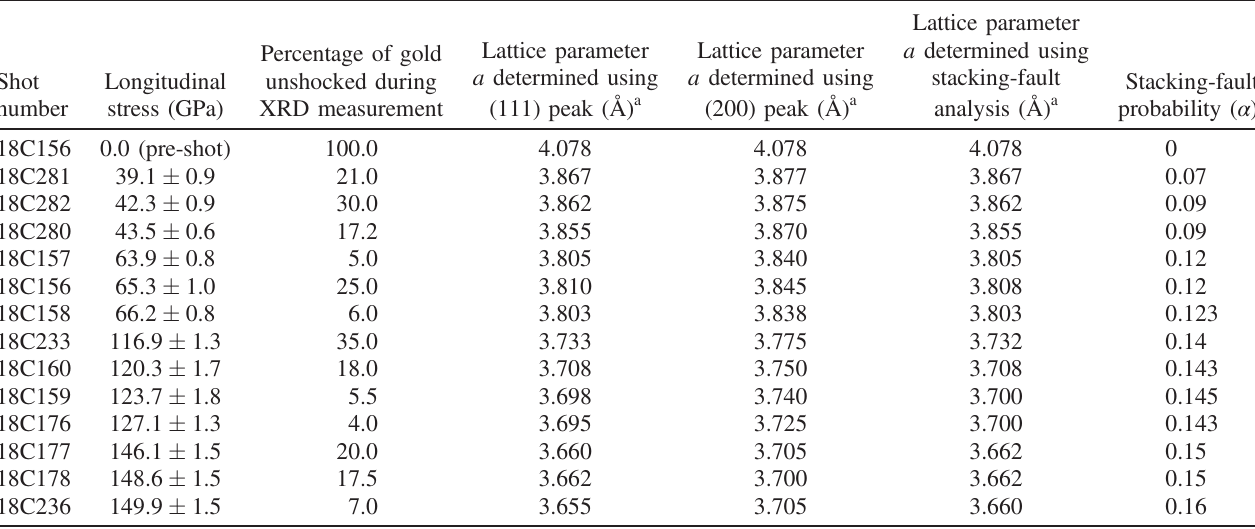
TABLE I. Results for Au laser shock experiments.